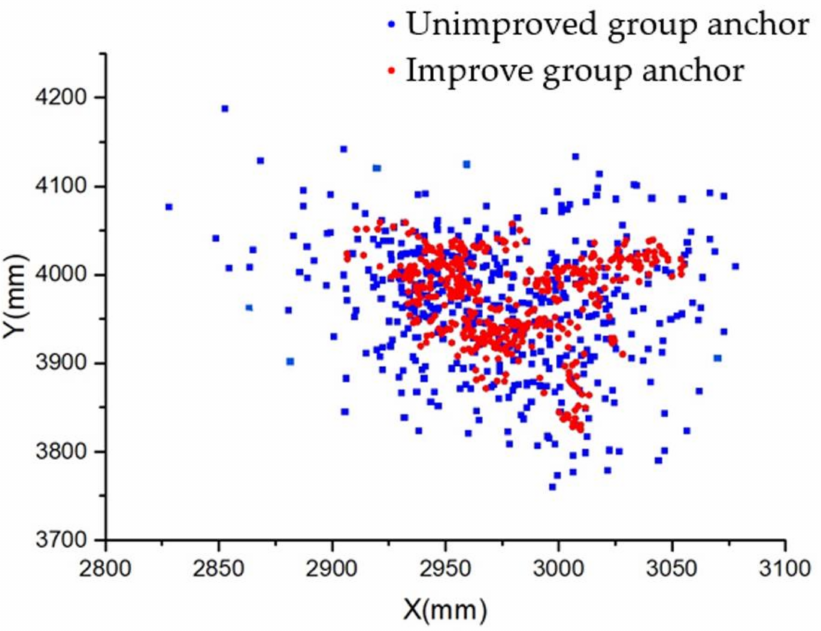
Figure 5. Comparison of static